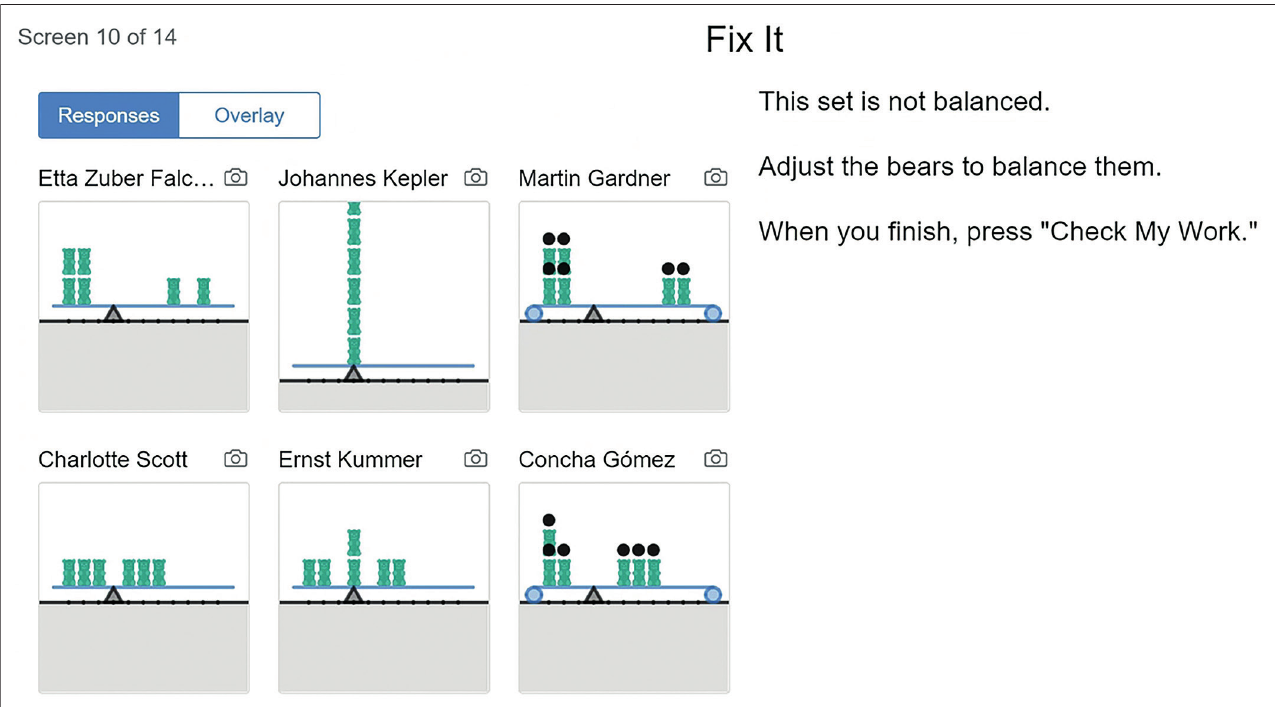
FIGURE 4: Data on Desmos during one of the virtual classrooms showing how a group of students solved the balancing tasks to understand a set’s mean value. This example is Screen 10 of 14.